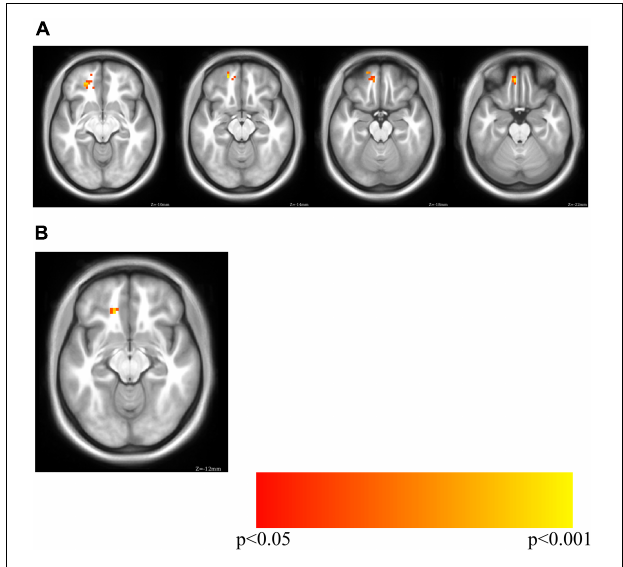
FIGURE 3 | PHQ-8 regression for sgCC connectivity seedmaps for (A) Cohort 1 (MNI Z of –10 to –22 in steps of 4) and (B) overlap between Cohort 1 and Cohort 2 (MNI Z of –12). Cohort 1 PHQ-8 results were masked with the volume-corrected cluster identified in the Cohort 1 phone usage analysis (unlock duration) and Cohort 2 PHQ-8 results were masked with the PHQ-8 results from Cohort